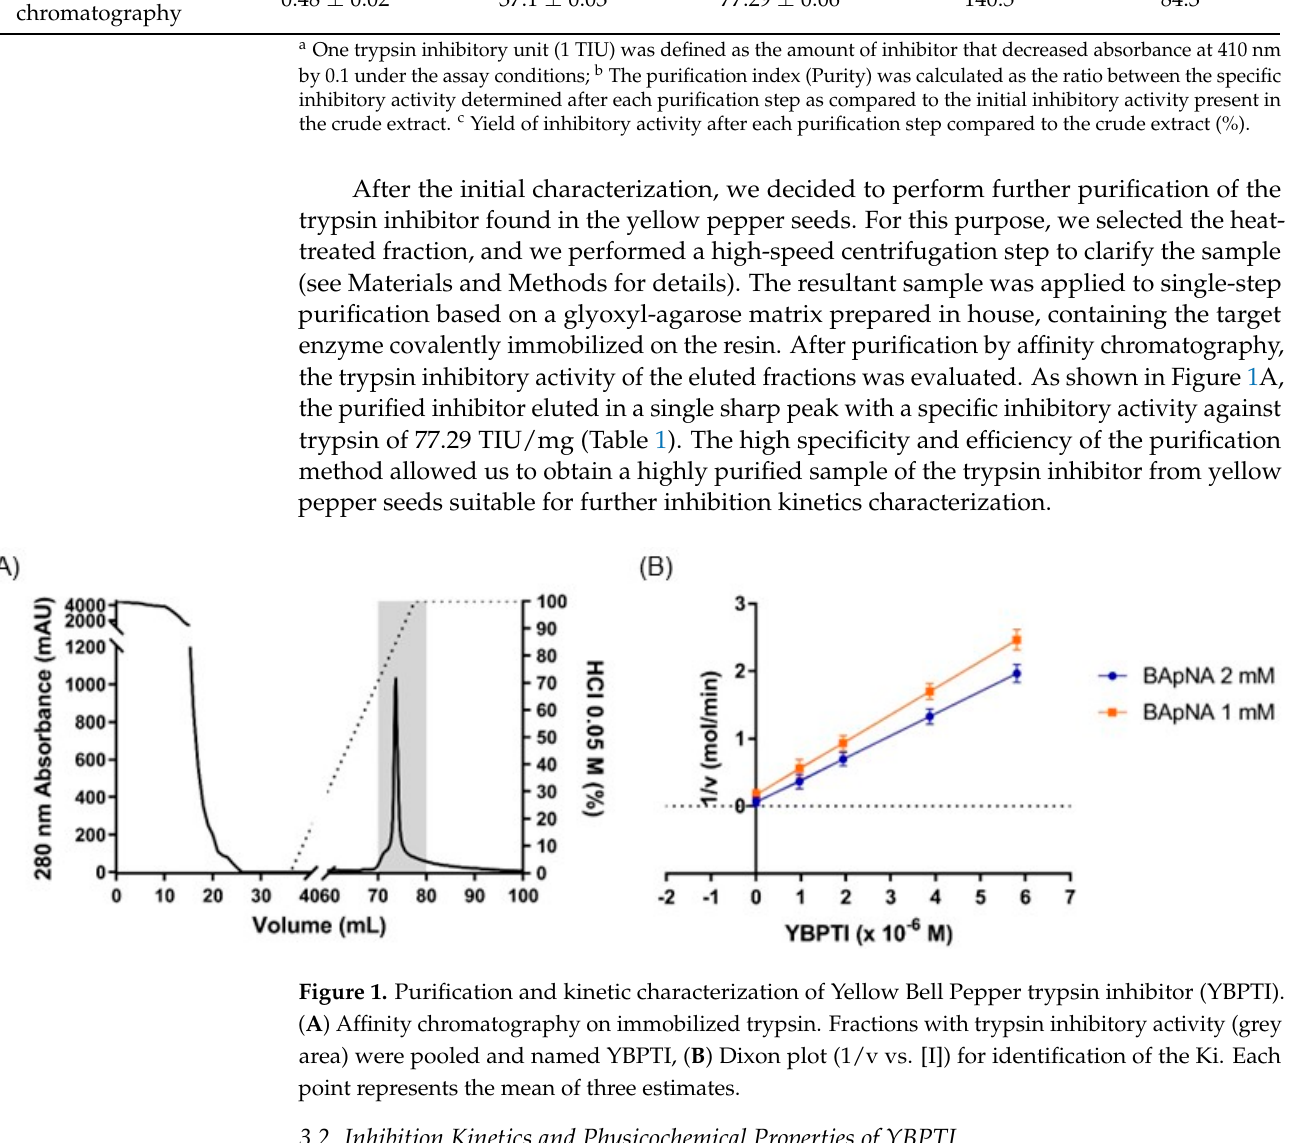
Table 1. Trypsin inhibitory activity.